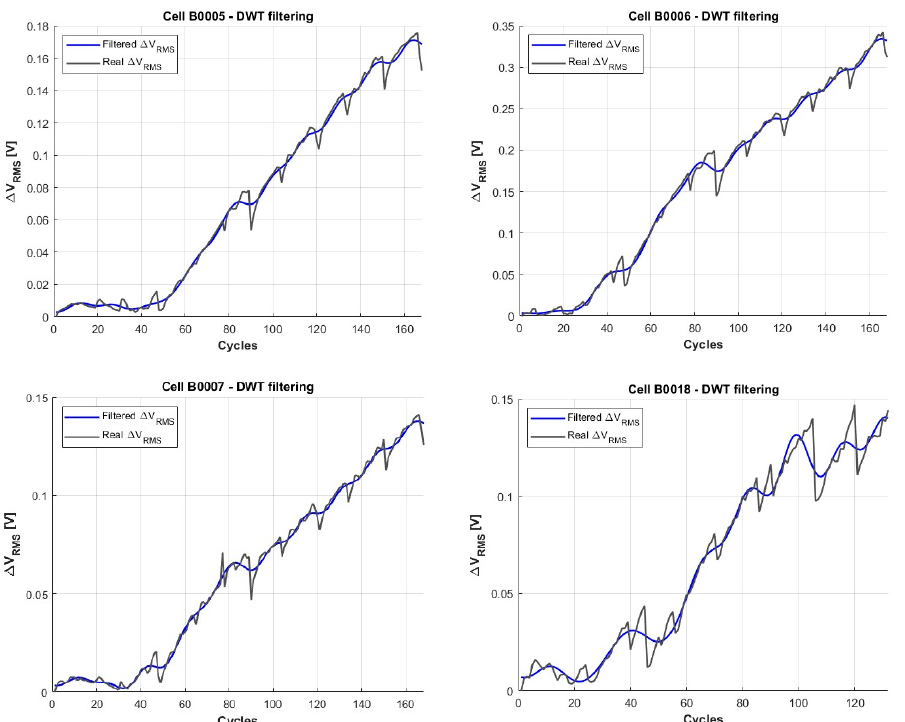
nal, its approximation or fi ltered signal, and the three details removed from the original signal, corresponding to successive high-pass fi lters.